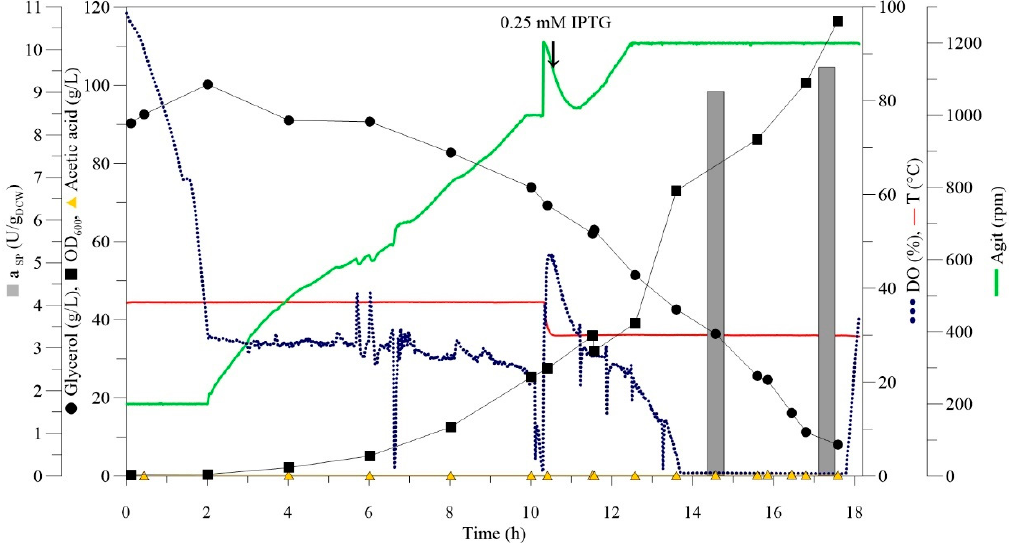
Figure 1. HCD batch fermentation of E. coli expressing SMO performed on the 1.5 L scale. Table 1. Results of HCD